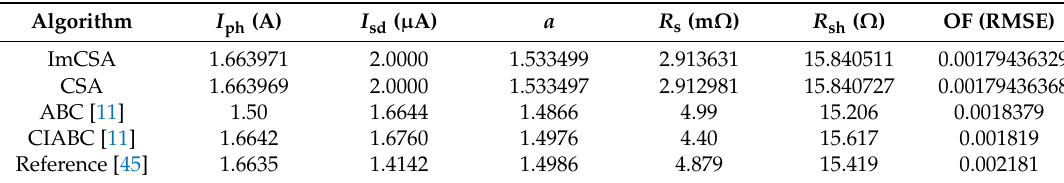
Table 14. Comparison among various parameter estimation algorithms for the PMM of monocrystalline STM6-40/36